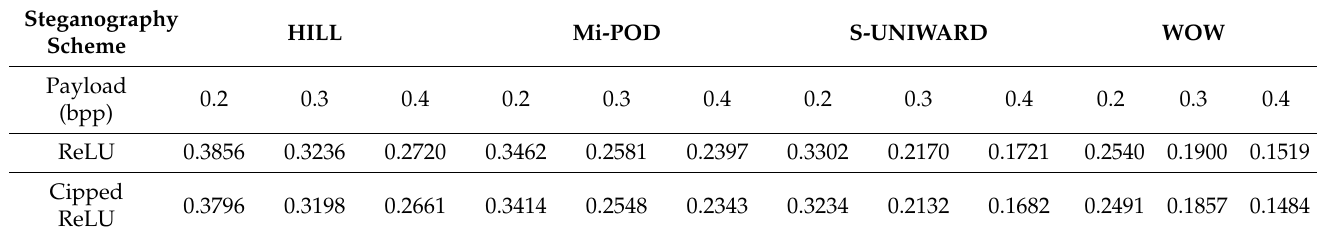
Table 4. Detection errors using ReLU and clipped ReLU.